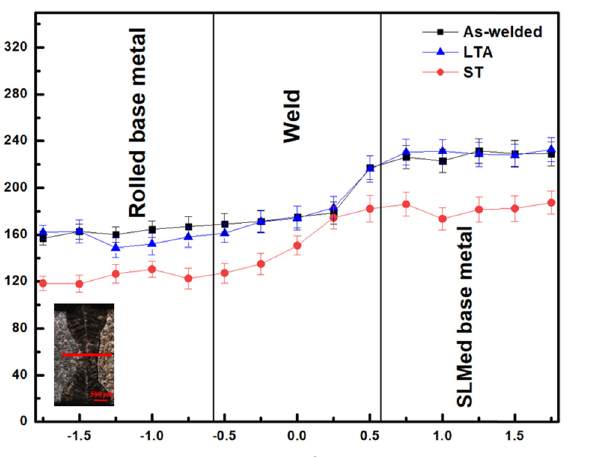
Spectrum Phases Cr